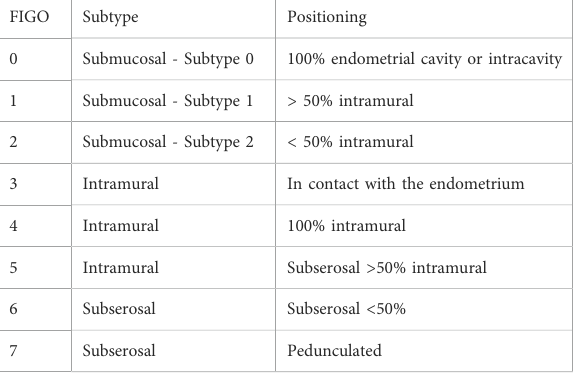
TABLE 1 Classi fi cation of uterine fi broids by FIGO. Classi fi cation of uterine fi broids by anatomical